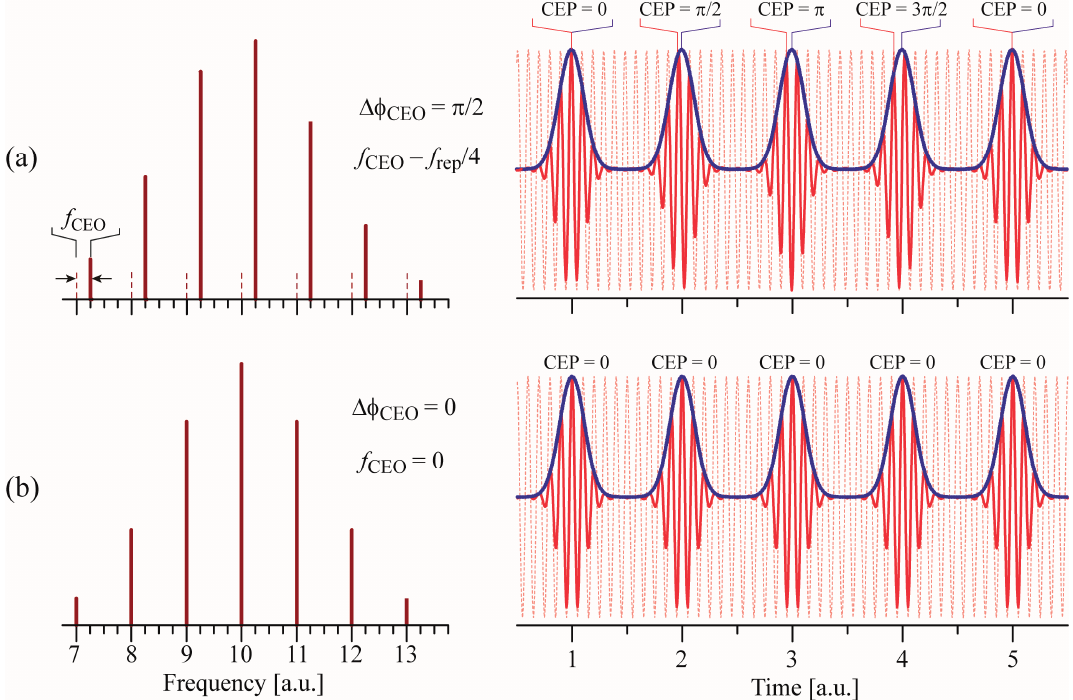
Figure 7. Illustrative examples of the correspondence between frequency (left) and time (right) representations of a pulse train emitted by a modelocked laser [51]. The red oscillation shows the evolution of the carrier and the blue line represents the pulse envelope. ( a ) f CEO = f rep /4, Δ(cid:2038) = π 2⁄ : an identical pulse is retrieved after four pulses; (cid:2887)(cid:2889)(cid:2899) ( b ) f CEO = 0, Δ(cid:2038) = 0 : all pulses are identical (shown here for the particular case where (cid:2887)(cid:2889)(cid:2899) CEP = 0, however, the absolute value of CEP can be